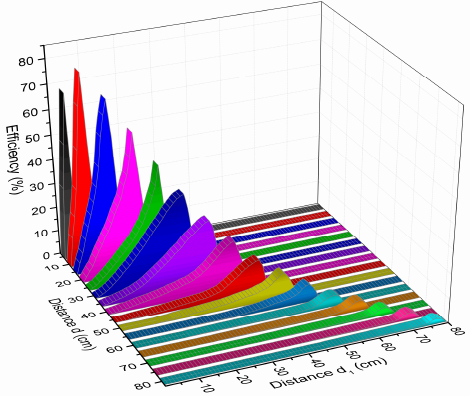
Figure 3. Power efficiency simulation results for the position of relay resonator from the transmitter with respect to the distance between transmitter and receiver resonators.